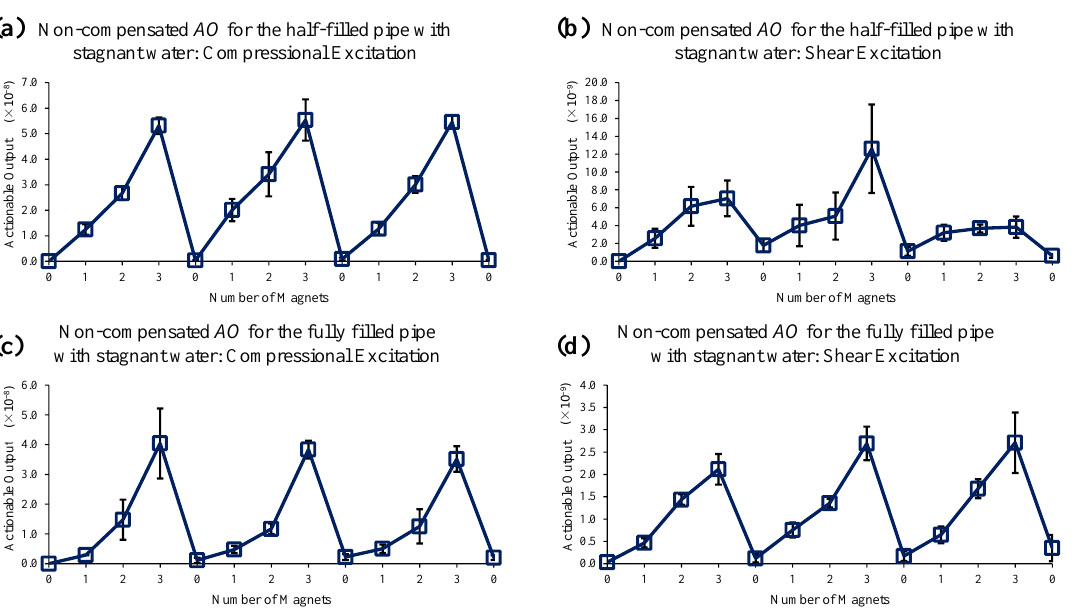
Figure 11. Changes in AO with the different number of magnet perturbations for the half-filled pipe with ( a ) compressional and ( b ) shear excitations, and for the fully filled pipe with ( c ) compressional and ( d ) shear excitations. No EOC compensation method is applied.